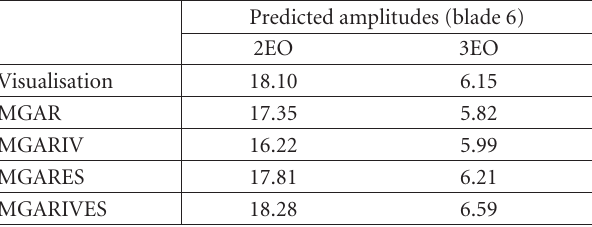
Table 10: Amplitude estimates